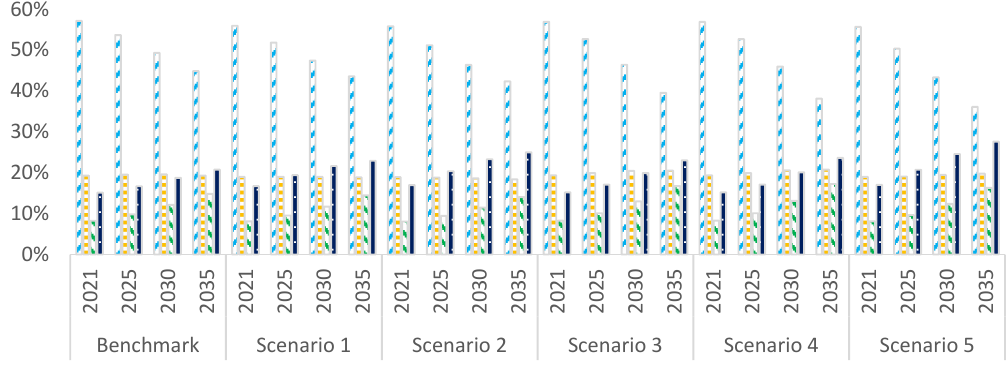
Figure 2. Simulation of energy consumption composition in different scenarios.